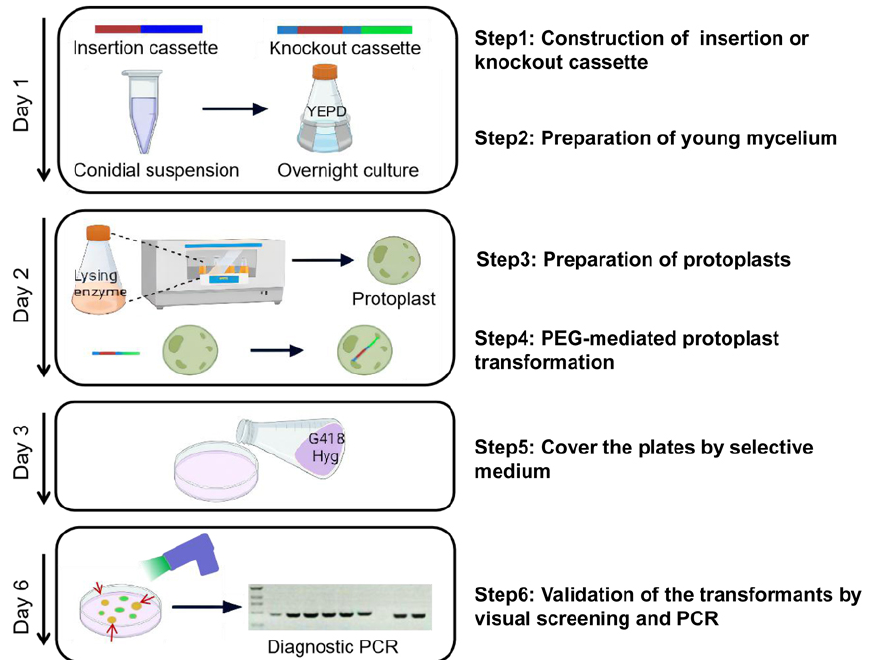
Figure 6. Flowchart of the visualized gene deletion system. This system is based on PEG-mediated protoplast transformation and fluorescence visualization. The insertion cassette or knockout cassette was amplified from the constructed vector. The conidia were cultured overnight to obtain fresh mycelium and then made into protoplasts by lysing enzymes. After that, the targeted cassette was transformed into protoplasts by PEG-mediated transformation. The primary transformation plates were covered with selective medium containing the appropriate concentration of antibiotics the next day. Finally, the candidate plates were illuminated for 3 s using a hand-held lamp, and nonfluorescent putative deletion transformants were further confirmed by PCR. The entire process could be accomplished successfully within a week.